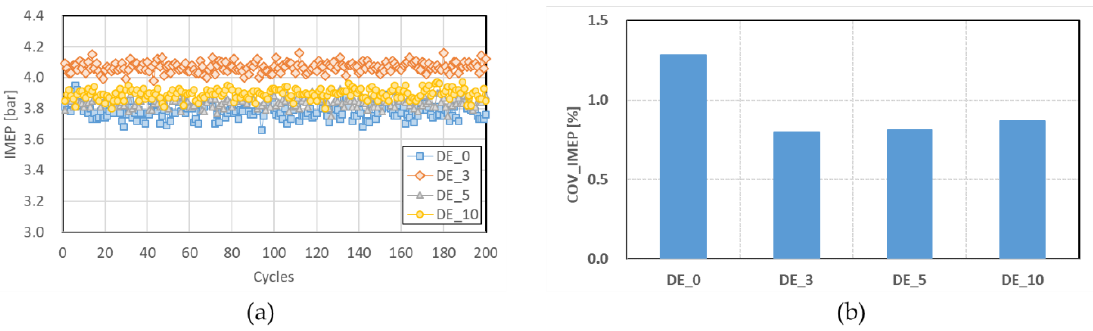
Figure 7. ( a ) Distributions of the IMEP and ( b ) the COV of the IMEP.